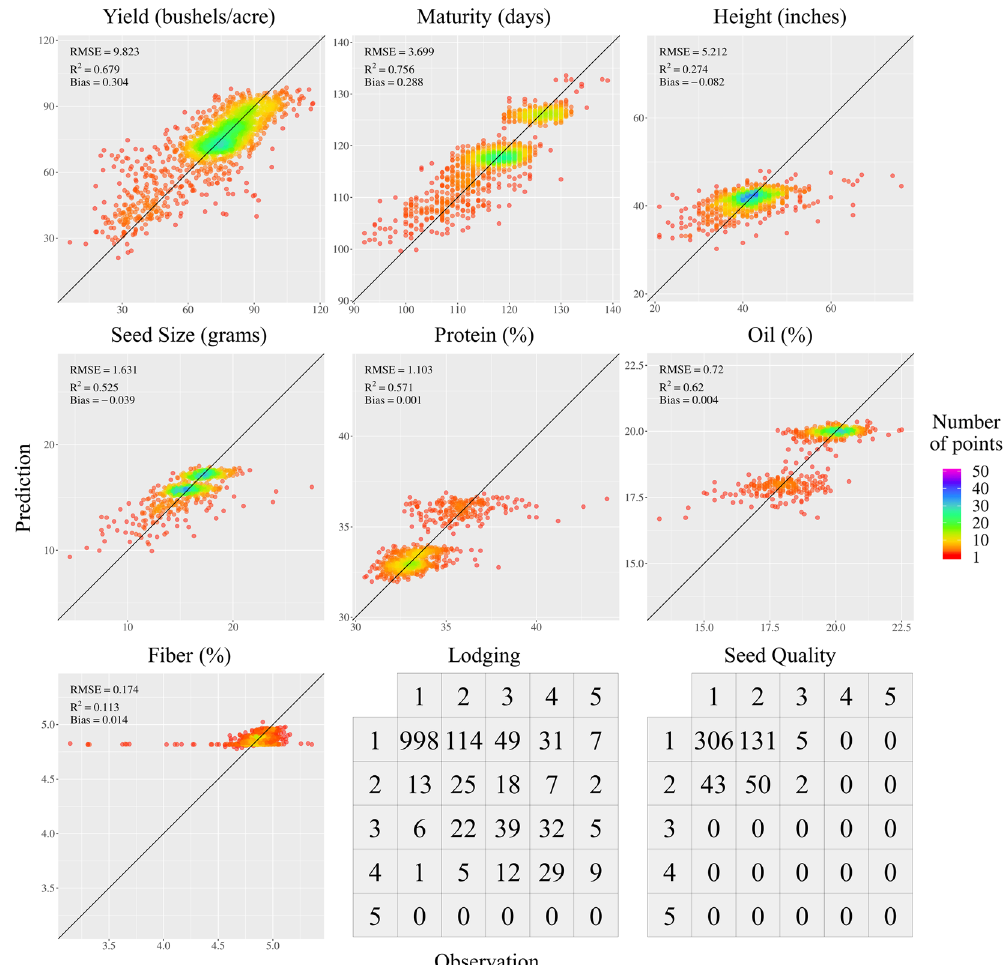
Figure 7. Prediction results for nine soybean traits using all 457 predictor